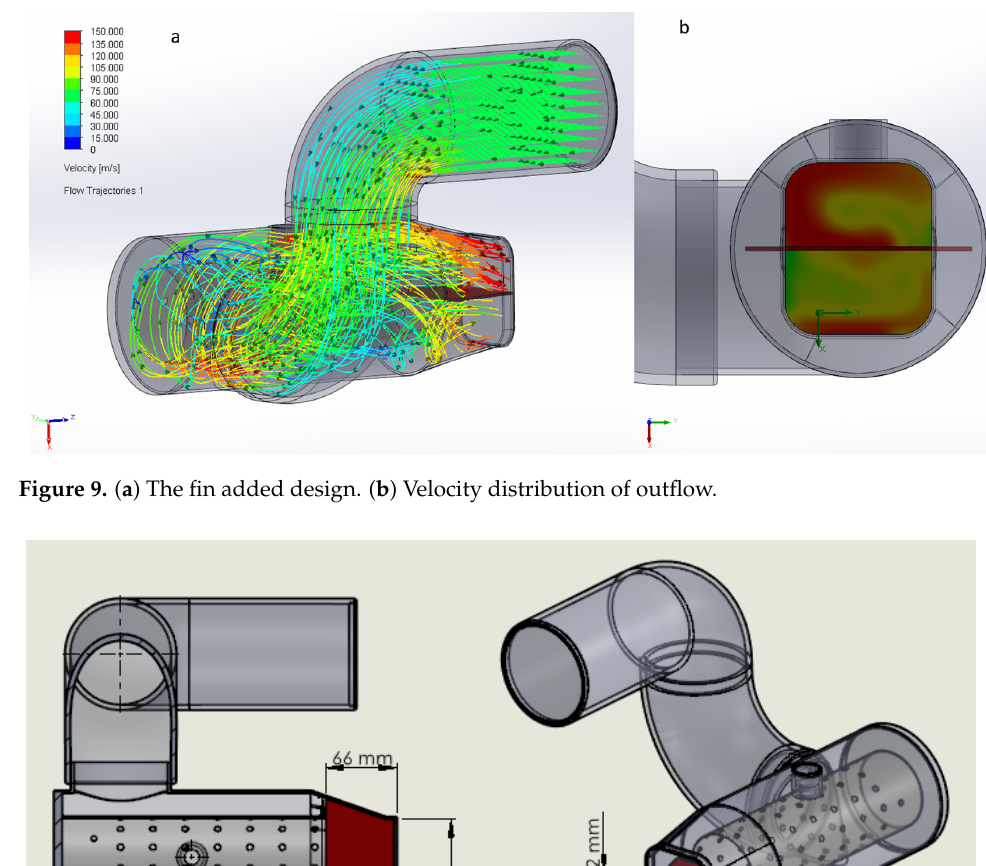
Figure 10. Dimensions of the fin added to the turbine intake.